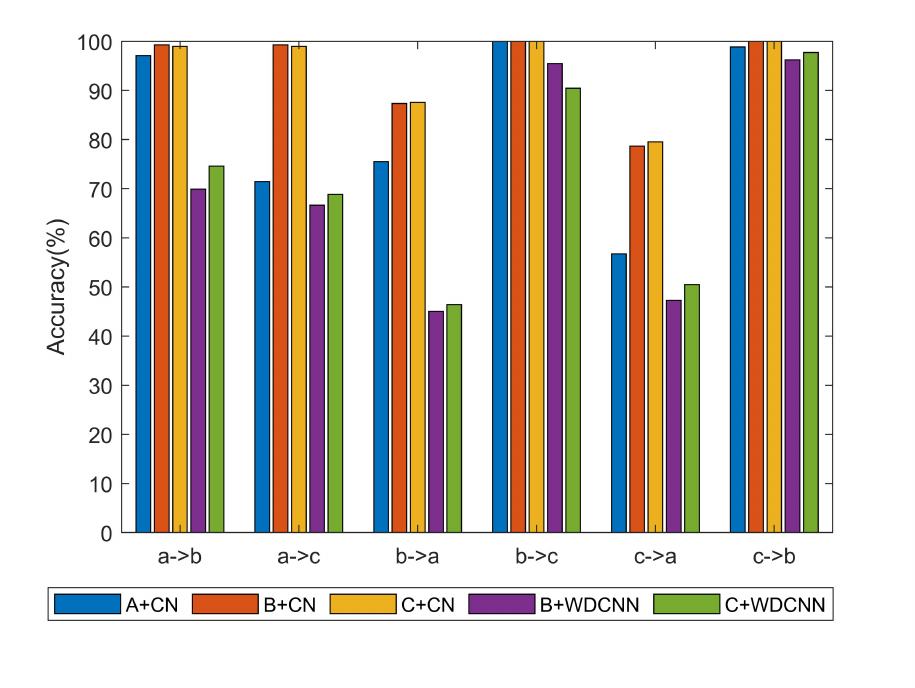
Figure 12. Comparison of the accuracy of different methods at different rotational